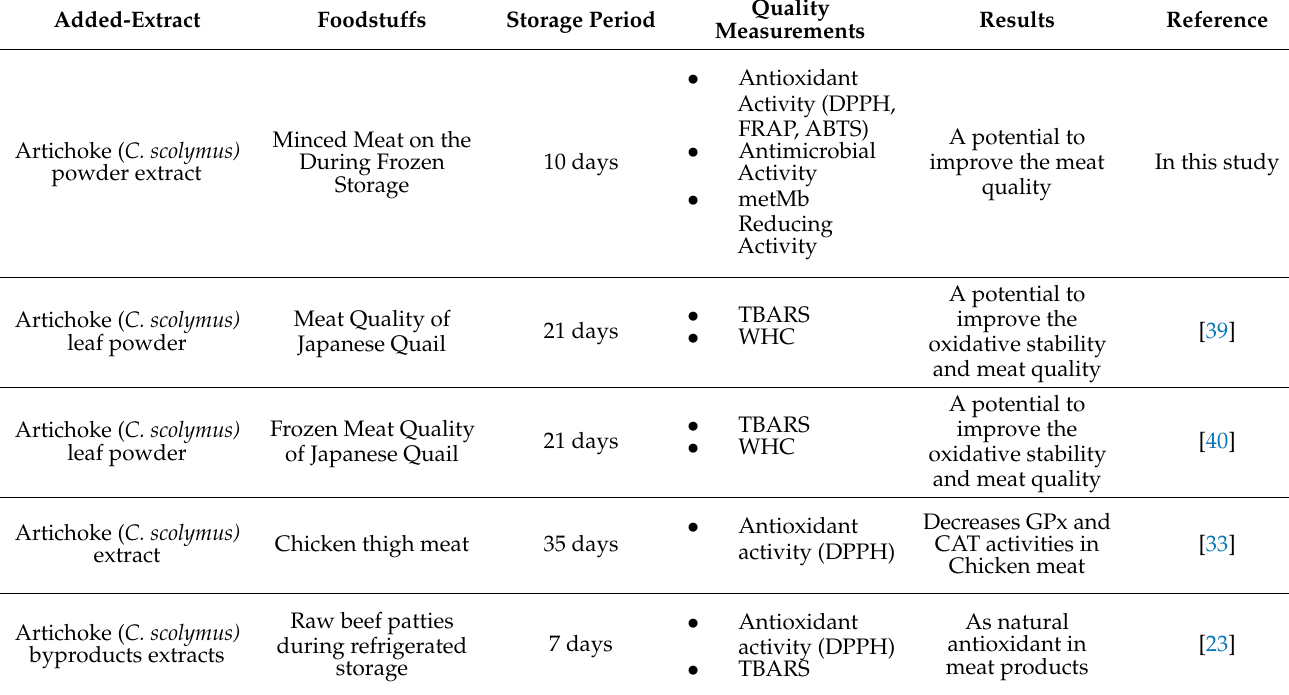
Table 4. Effect from different references of artichoke ( C. scolymus) powder on the quality performances on meat products.